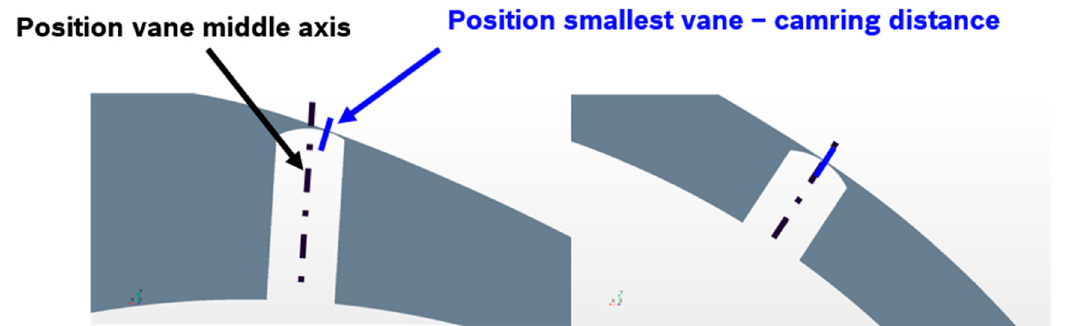
Figure 4. Variable contact point due to different radii of cam ring and vane tip.